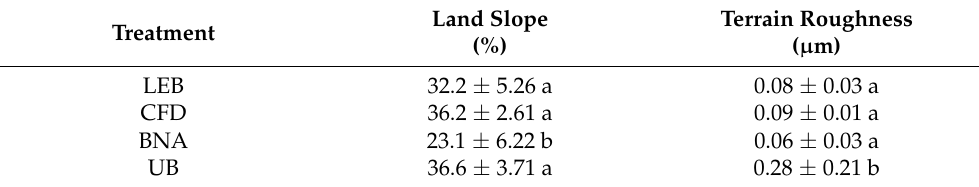
Table 3. Values (mean ± standard deviation) of land slope and terrain roughness in the small-scale areas under four land conditions in Sierra de los Donceles forest (Castilla-La Mancha,